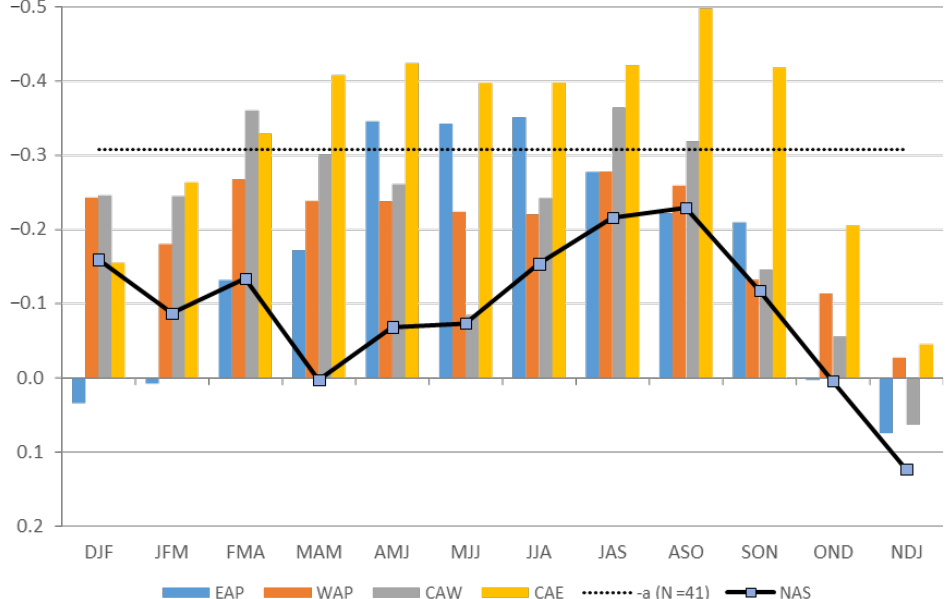
Figure 6. Spearman’s rank correlation coefficients between the January ONI and MERRA-2 3-month dust column mass density series for the four subregions during 1980–2021, with NAS for comparison. Additionally shown in the figure is the critical correlation coefficient value ( rho = − 0.3082) corre- sponding to the 0.05 significance level (N = 41, for series when months of the previous year were used). Note that the Y -axis is displayed in reverse order.